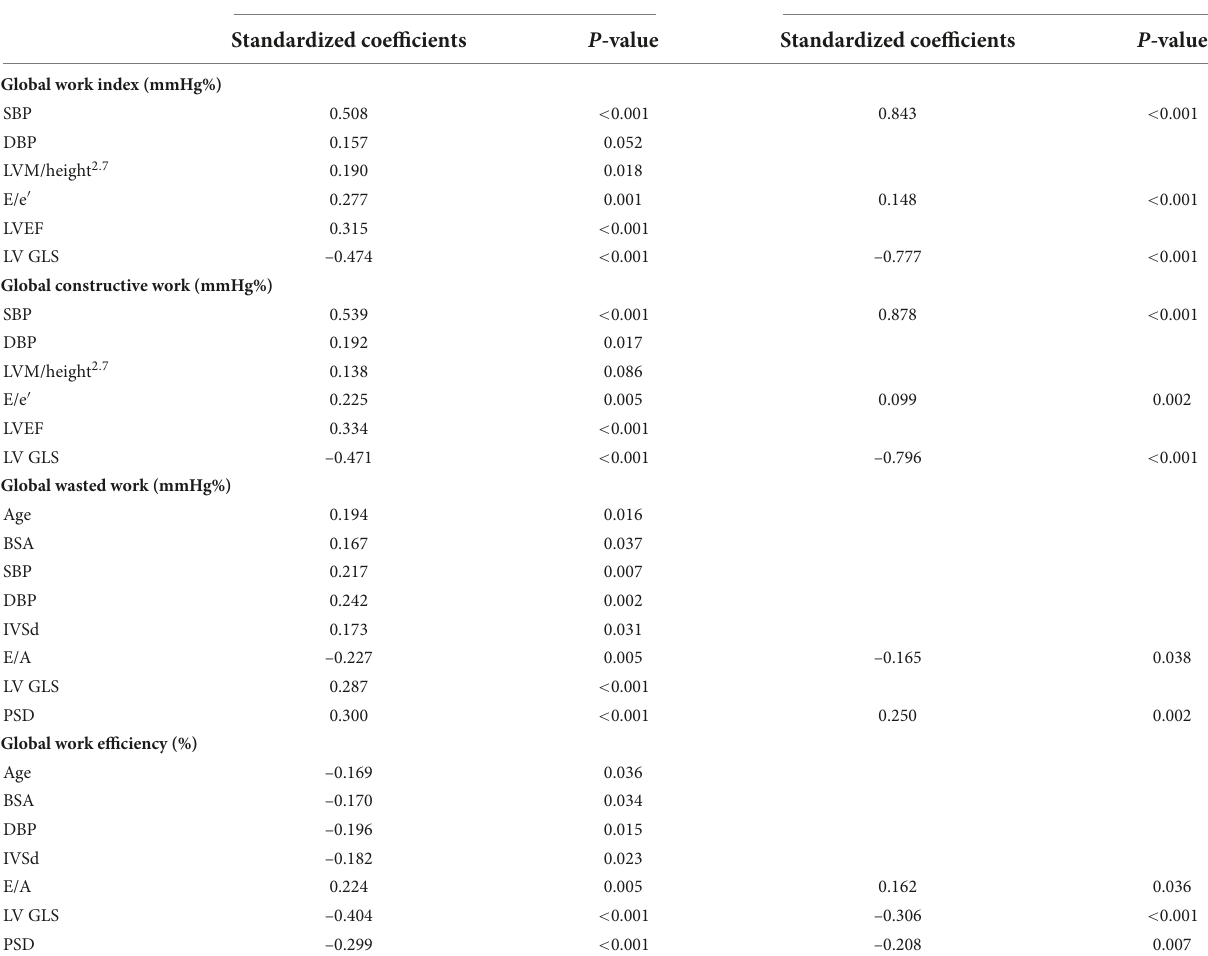
TABLE 4 Univariable and multivariable analysis for global myocardial work parameters.